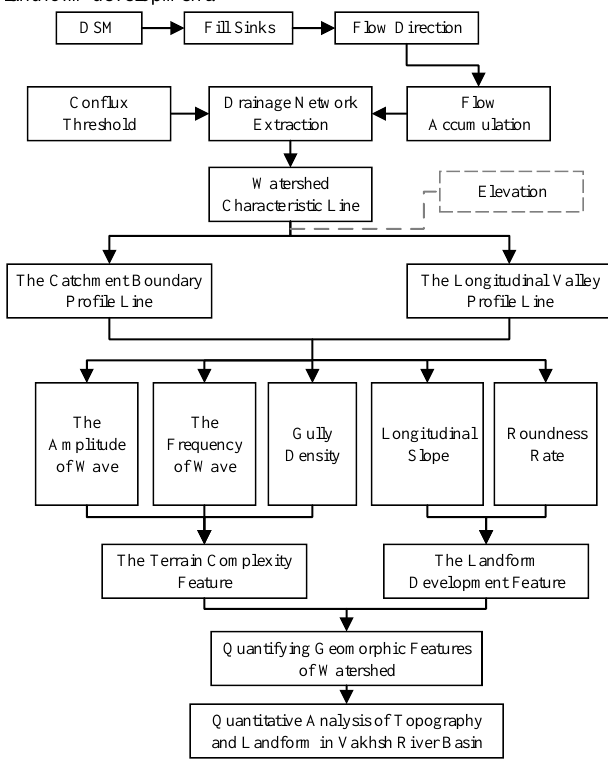
Figure 3. Experimental scheme